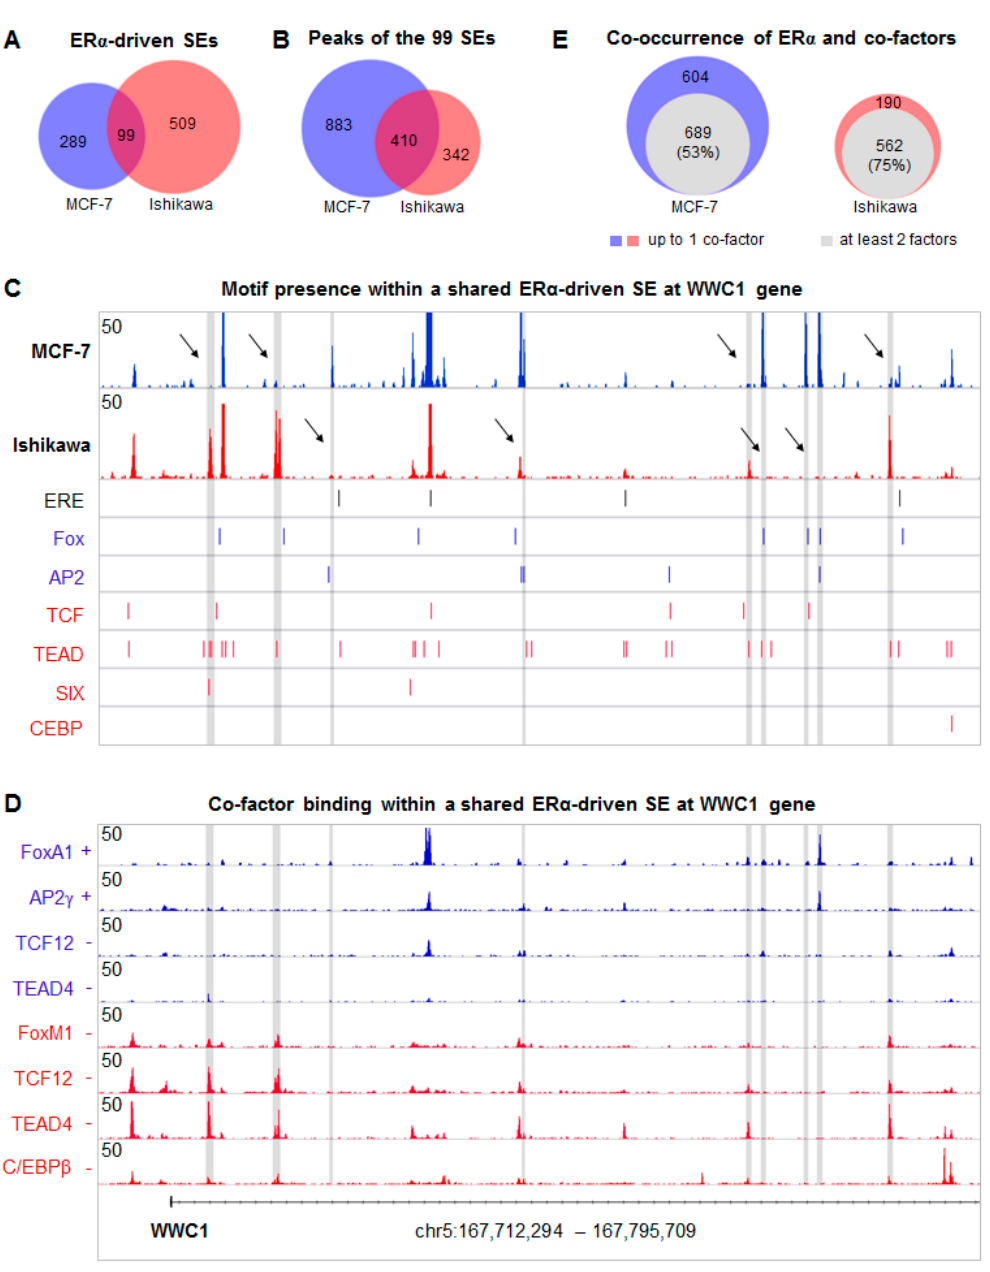
Figure 4. Shared ER α -driven super-enhancers are composed of different transcription factor binding sites in MCF-7 and Ishikawa cells. ( A , B ) Area-proportional Venn diagrams representing the overlap between all ER α -driven SEs of MCF-7 and Ishikawa cells (A) and the overlap between the constituents of the 99 shared SEs ( B ). ( C ) The Integrative Genomics Viewer (IGV) snapshot of ER α ChIP-seq coverage on the WWC1 locus showing a SE that is formed upon E2 treatment in both MCF-7 and Ishikawa cells. The interval scale is 50. The matrix of ERE, Fox, AP2, TCF, TEAD, SIX, and CEBP motifs was mapped within the summit ± 50-bp regions of the ER α peaks, and their putative elements were represented as thin lines (bottom part of the panel). Peaks marked with arrows and highlighted in grey show different binding patterns between MCF-7 and Ishikawa cells. ( D ) The IGV snapshot representing FoxA1, AP2 γ , TCF12, and TEAD4 ChIP-seq coverage in MCF-7 and FoxM1, TCF12, TEAD4, and C/EBP β ChIP-seq coverage in Ishikawa cell line upon vehicle [ − ] or E2 [+] treatment. The interval scale is 50, in all cases. ( E ) Area-proportional Venn diagrams show the proportion of the total 1,293 MCF-7 and 752 Ishikawa-specific ER α peaks (defined on panel B) that show co-occurrence with at least two other TFs.